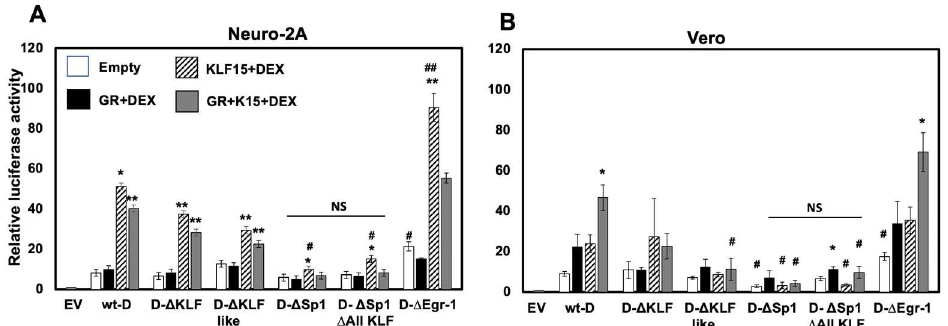
Figure 7. Transactivation of fragment D constructs and mutants by GR, KLF15, and/or DEX. Neuro-2A ( Panel A ) or Vero ( Panel B ) cells were incubated in 2% stripped FBS, and transfected with 0.5 ug of wt-D construct or denoted mutant constructs and Renilla luciferase plasmid (0.05 ug). Where indicated, samples were co-transfected with GR (1 ug) and/or KLF15 (0.5 ug) expression plasmids. Empty vector (pGL4.24[luc2P/minP]) was added to cultures to maintain the same DNA amount. 24 h after transfection, certain cultures were treated with DEX (10 uM) as denoted. Cells were harvested at 48 hrs, and dual luciferase assays were performed. Luciferase activity was calculated relative to the empty vector luciferase activity. Results are the mean of three experiments, and error bars denote standard error. An * denotes a significant difference in a luciferase construct when compared to the luciferase construct cotransfected with GR and/or KLF15 and treated with DEX. A # denotes a significant difference in the mutant luciferase construct compared to relevant wt D transfected samples. A */# denotes a significant difference at p < 0.05, whereas a **/## denotes a significant difference as p < 0.005, as determined by Student’s t-test. NS denotes a non-significant difference between the denoted constructs.